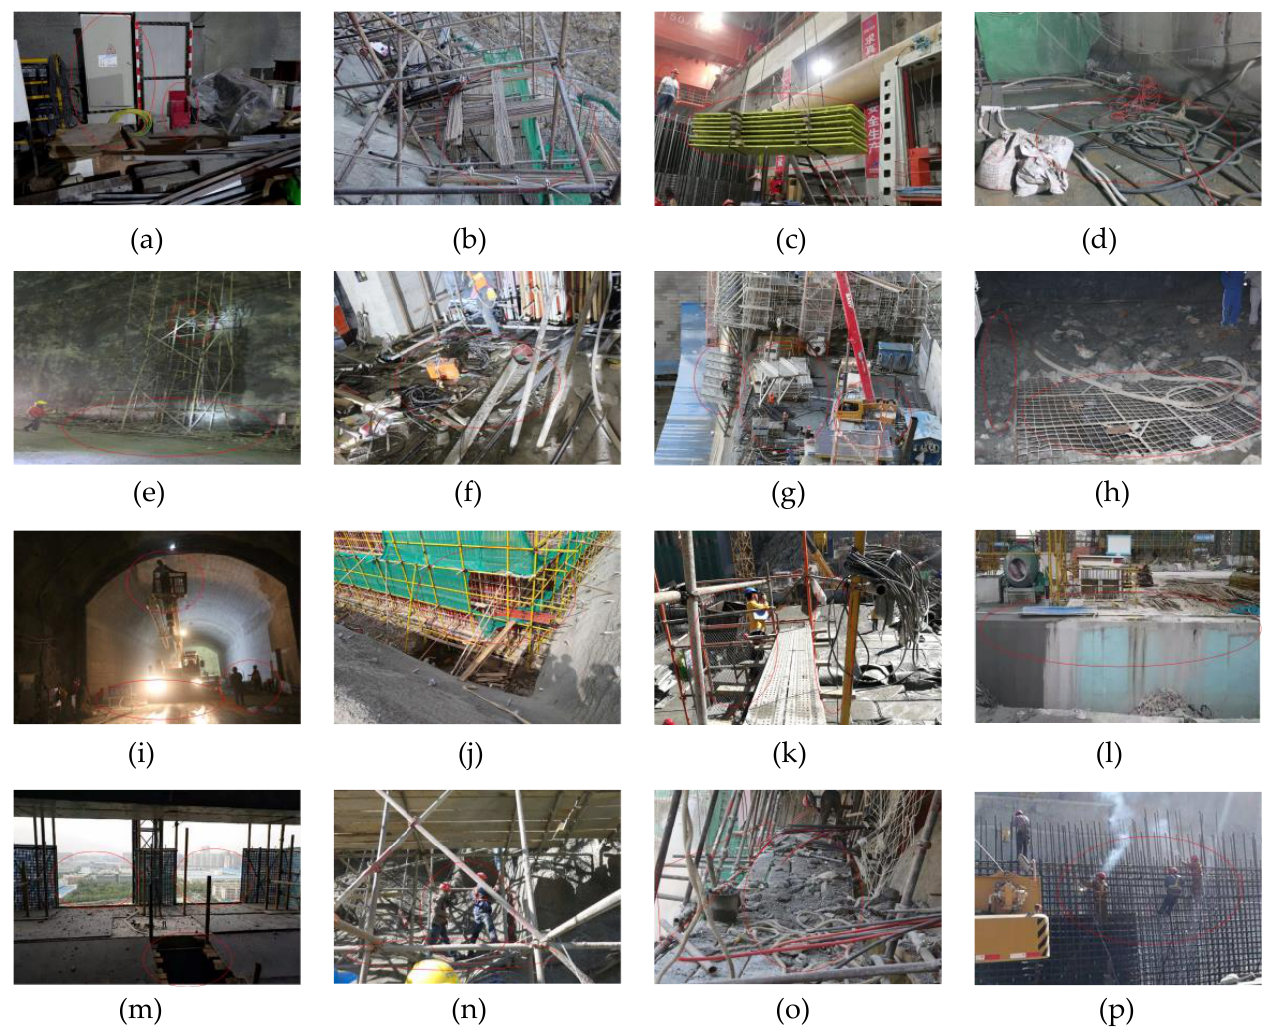
Figure 3. Photographs of the construction site used for the experiment: ( a ) dark, messy; ( b ) bright, messy; ( c ) dark, tidy; ( d ) dark, messy; ( e ) dark, tidy; ( f ) dark, messy; ( g ) bright, messy; ( h ) dark, messy; ( i ) dark, tidy; ( j ) dark, tidy; ( k ) bright, tidy; ( l ) bright, messy; ( m ) dark, tidy; ( n ) bright, tidy; ( o ) bright, messy; ( p ) bright, tidy.